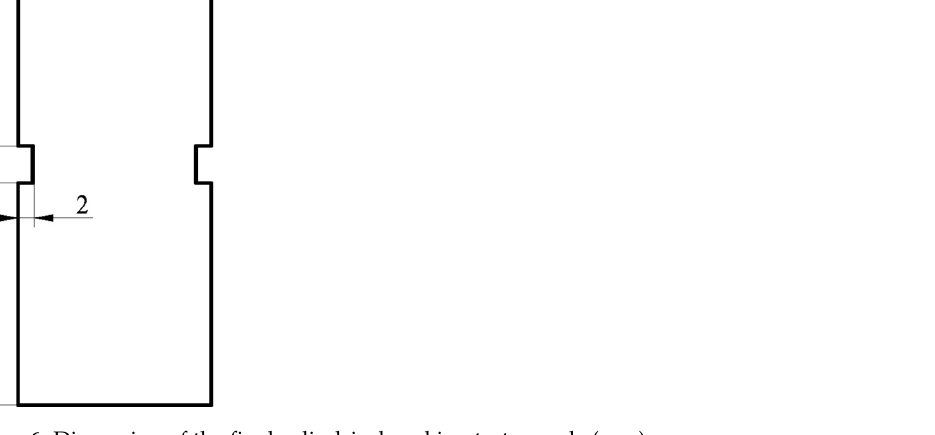
Figure 6. Dimension of the final cylindrical necking test sample (mm).